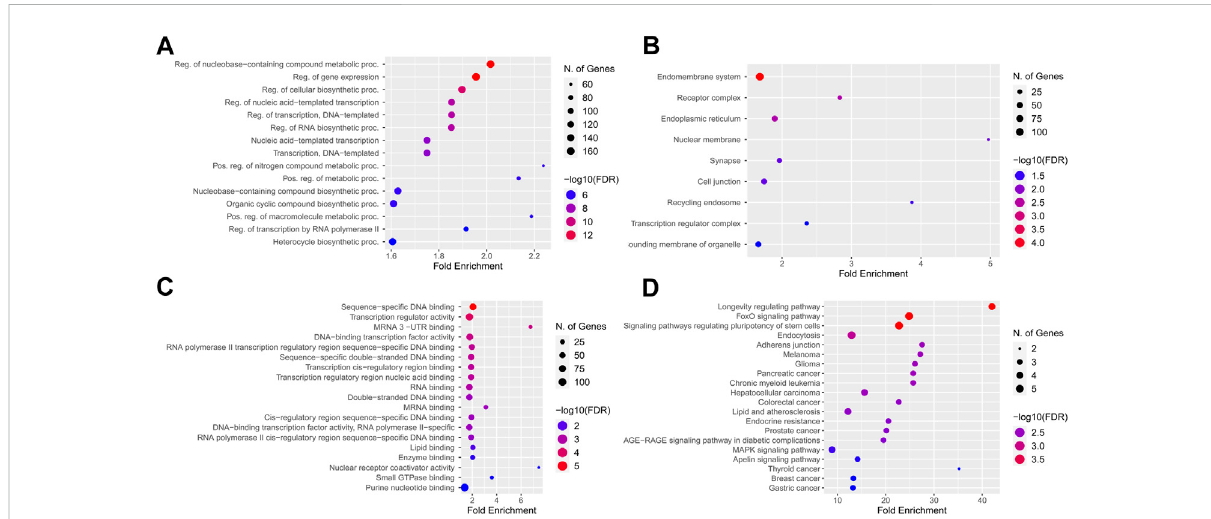
FIGURE 7 KEGG pathway enrichment and Gene ontology analysis best- fi tted target genes. (A) Biological process term (BP) association with nucleobase containingcompoundmetaboliteprocessandregulationofgeneexpression. (B) Endomembranesystemofcellswerethecellularcomponents(CC) mostinvolvedregardingtargetedgenes. (C) Inmolecularfunction(MF)categories,targetgenesareassociatedwithsequence-speci fi cDNAbinding, andtranscriptionregulatoryactivity. (D) Longevityregulationpathway,FOXOsignalingpathwayandsignalingpathwaysregulationpluripotency of stem cells had best enrichment ratio and the more signi fi cant number of identi fi ed targets in KEGG pathway